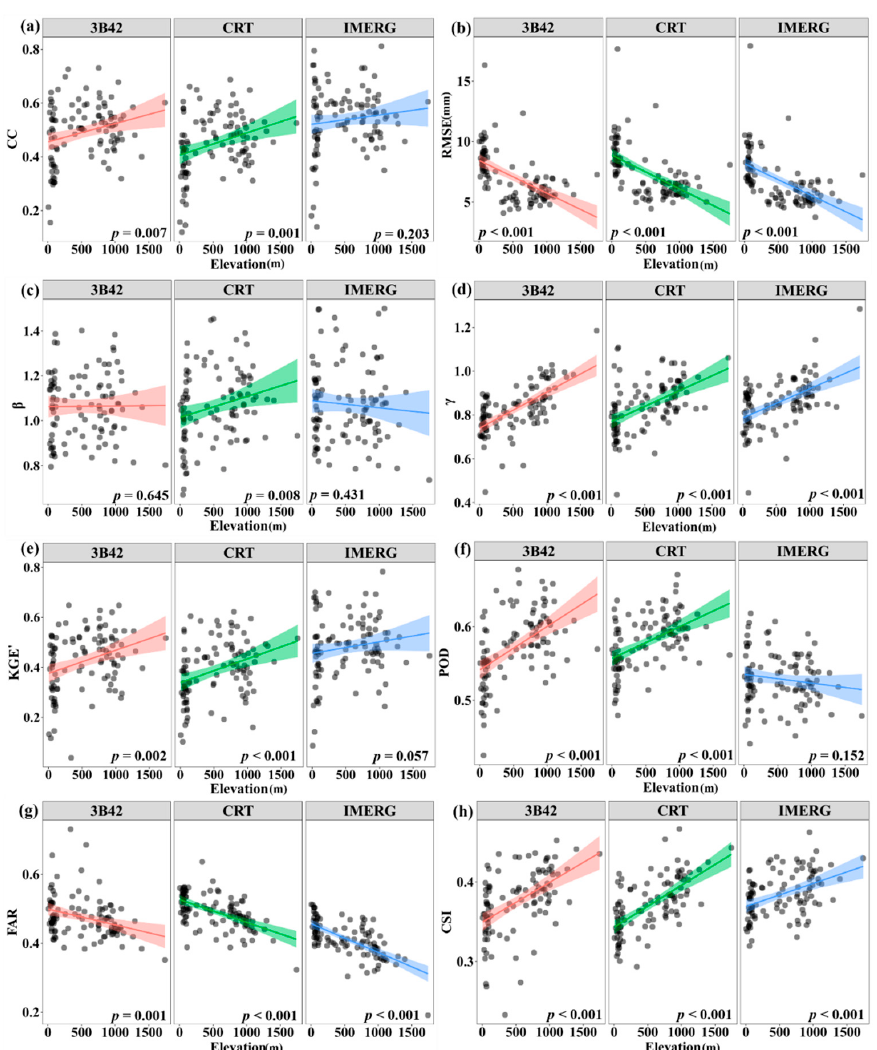
Figure 3. Relationship between evaluation metrics and elevation for 3B42, CRT, and IMERG based on linear regression model. Each dot represents a rain gauge. The straight line shows the liner trends estimated least squares error method. The p values of the significance test for the liner trend are shown in the figure accordingly. Figure ( a–h ) stands for the metrics of CC, RMSE, β , γ , KGE’, POD, FAR and CSI, respectively.